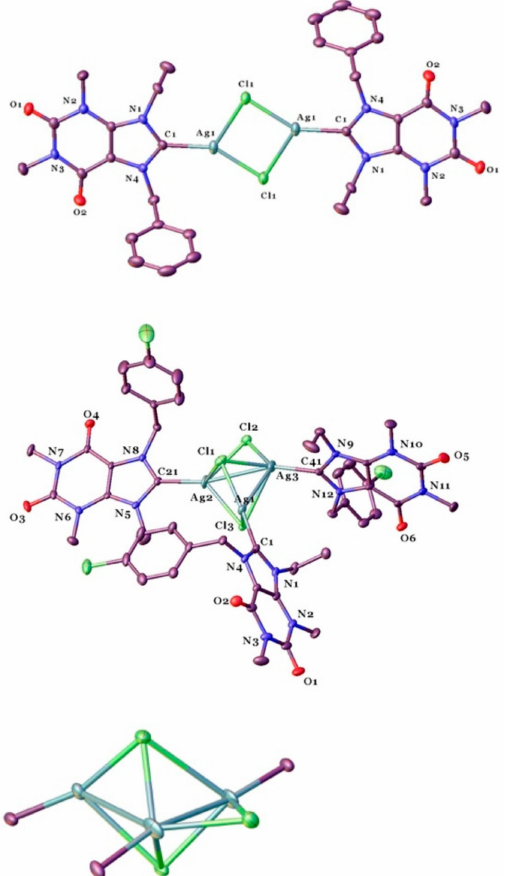
Figure 3. Molecular structures of compounds 9 (top) and 10 (center and bottom). Thermal ellipsoids are drawn at the 50% level. Hydrogen atoms have been omitted for clarity. Atoms labeled with an asterisk are generated by symmetry. The bottom image shows only the atoms directly attached to Ag in complex 10